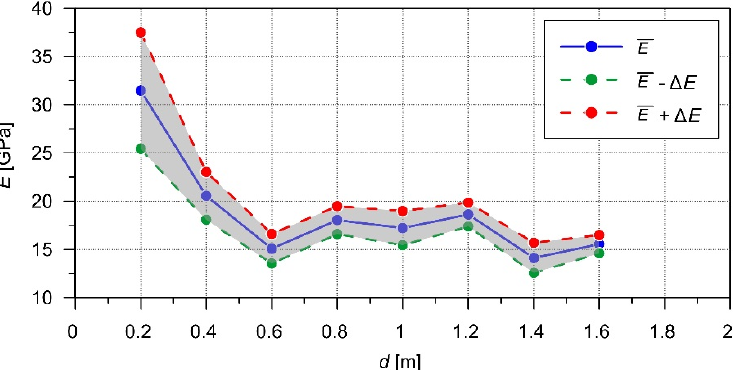
Figure 7. Young modulus estimation of wall CLS2 with the increase of distance between the two accelerometers: mean values (blue circles) and range values derived by a confidence interval of 95% of the R-wave velocities obtained by indirect test (red and green circles).